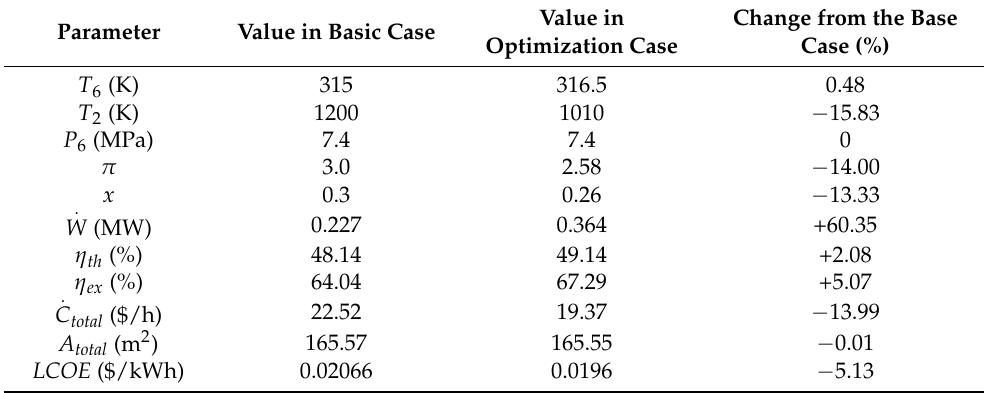
Table 11. Key operating parameters after cycle optimization